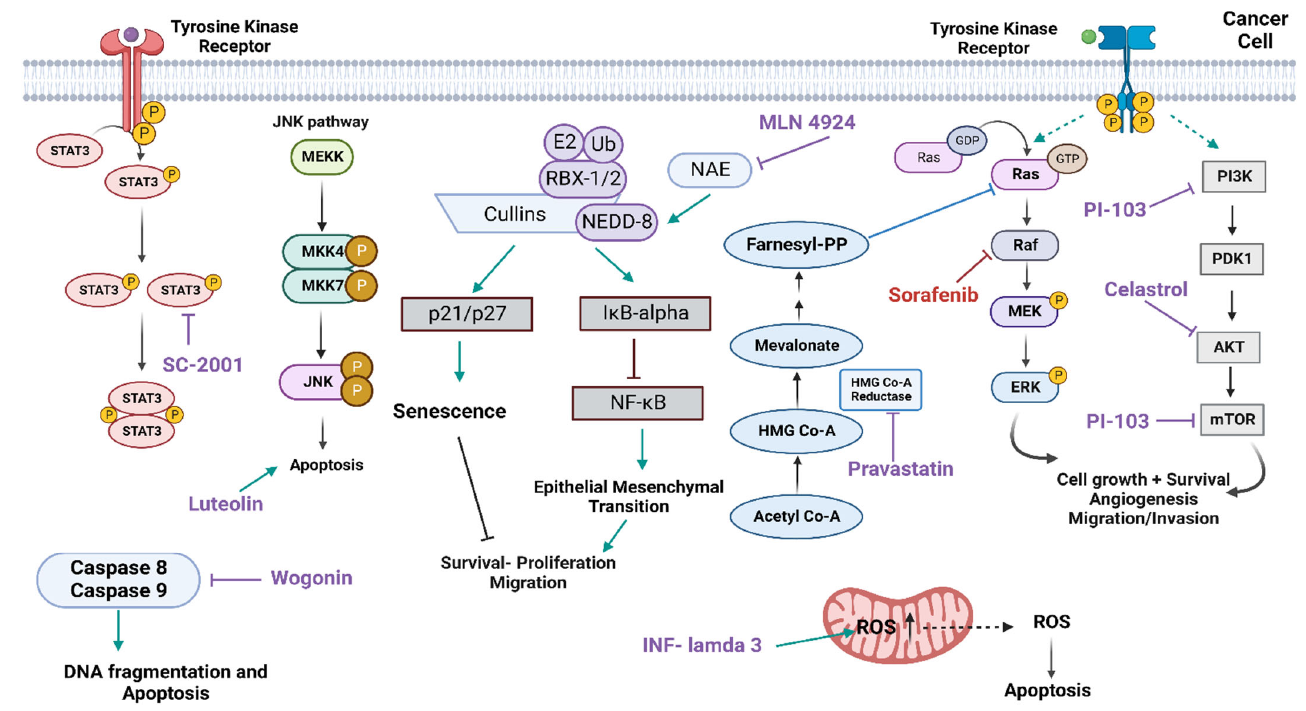
Figure 4. Schematic representation of combinational therapies of sorafenib and other small molecule inhibitors discussed in this review. This simplified schematic does not contain all signal transduction molecules known to be involved in the described signaling cascades but focuses on the targets discussed in this review. This figure was generated by biorender. STAT, Signal transducer and activator of transcription 3; JNK, c-Jun N-terminal kinase; NEDD-8, neural precursor cell expressed developmentally downregulated 8; NF- κ B, nuclear factor kappa light chain enhancer of activated B cells; HMG co-A, β -Hydroxy β -methylglutaryl-CoA; RAS, Rat sarcoma virus; MEK, Mitogen- activated protein kinase; ERKs, extracellular signal-regulated kinases; PI3K, Phosphatidylinositol 3-kinase; PDK1, 3-Phosphoinositide-dependent protein kinase 1; AKT, Ak strain transforming; mTOR, mammalian target of rapamycin; INF-lamda 3, Interferon lambda-3; ROS, Reactive oxygen species.